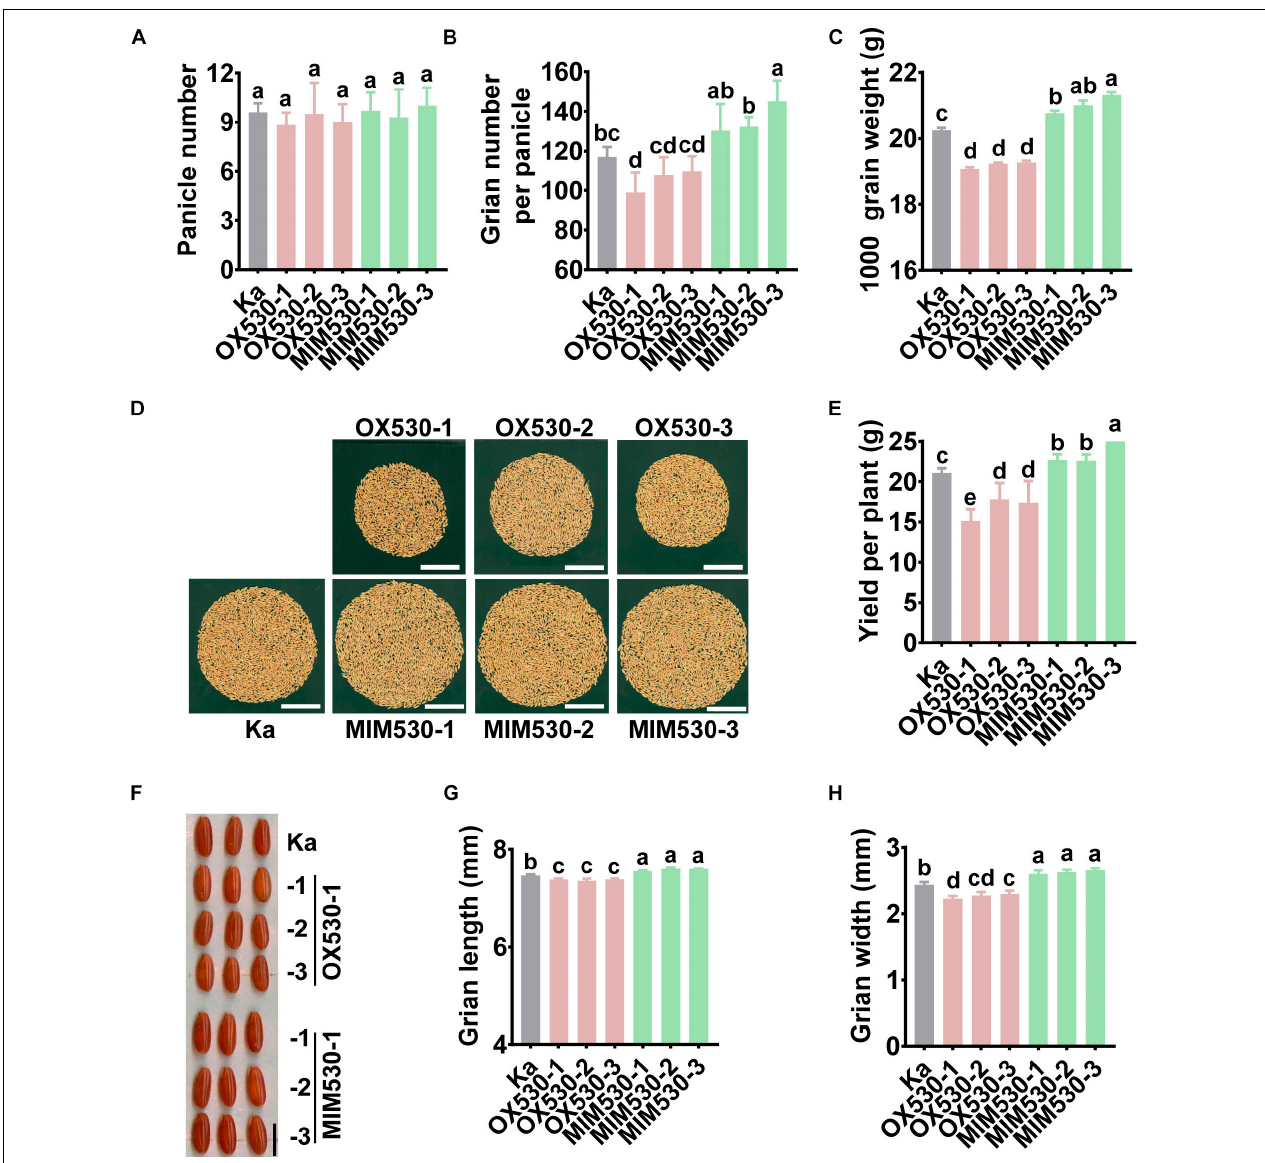
FIGURE 5 | Blocking miR530 enhances grain yield. (A–C,E,G,H) The panicle number per plant (A) , grain number per panicle (B) , grain weight (C) , yield per plant (E) , seed length (G) , and seed width (H) of the Kasalath control (Ka), OX530, and MIM530 planted in paddy yard in Wenjiang District, Chengdu City, Sichuan Province, China during the regular season from April to September in 2019. The data are shown as mean ± SD ( n = 10 independent plants). Different letters above the bars indicate significant differences ( P < 0.05) as determined by the one-way ANOVA analysis. (D) The photograph of grains per plant of the Kasalath control, OX530, and MIM530. Scale bars = 5 cm. (F) The husked seed morphology ( (F) , scale bars = 5 mm) of the Kasalath control, OX530, and MIM530.